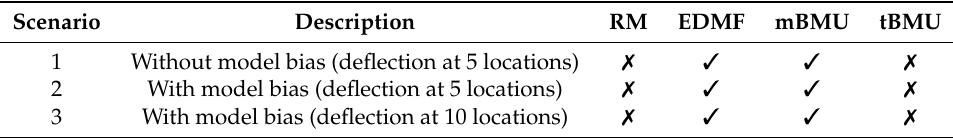
Summary of the accuracy of structural identification scenarios evaluated for the Crêt-de-l’Anneau Bridge. mBMU is modified BMU and tBMU is traditional BMU. Checkmarks imply accurate identification or model-class rejection and crosses imply inaccurate identification based on leave-one-out cross